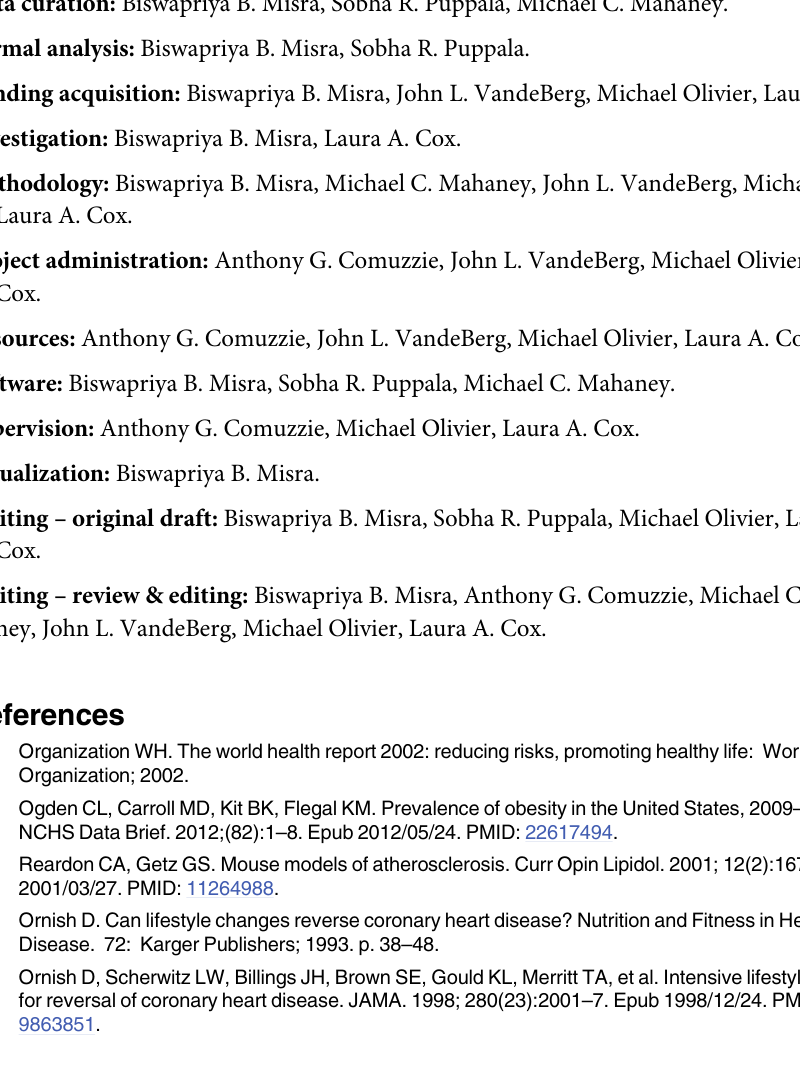
S8 Table. Pearson correlation matrix for metabolites and lesion burden for the HFHC baboons. S9 Table. Metabolites displaying correlation with total lesion burden at the 2 yrs time point. Table is displaying R, slope, T-statistics, and